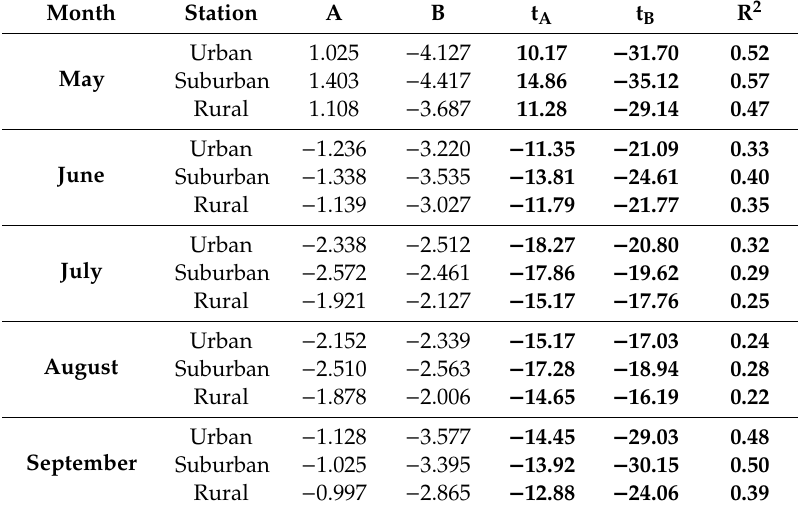
Table 6. Linear regression analysis of temperature anomalies with respect to SPEI for the three stations and for the months May to September of the years 1988–2017, showing the regression equation (T anomaly = A + B · (SPEI)), the t-test of the statistical significance of A and B, and the adjusted R 2 correlation coe ffi cients. Month Station A